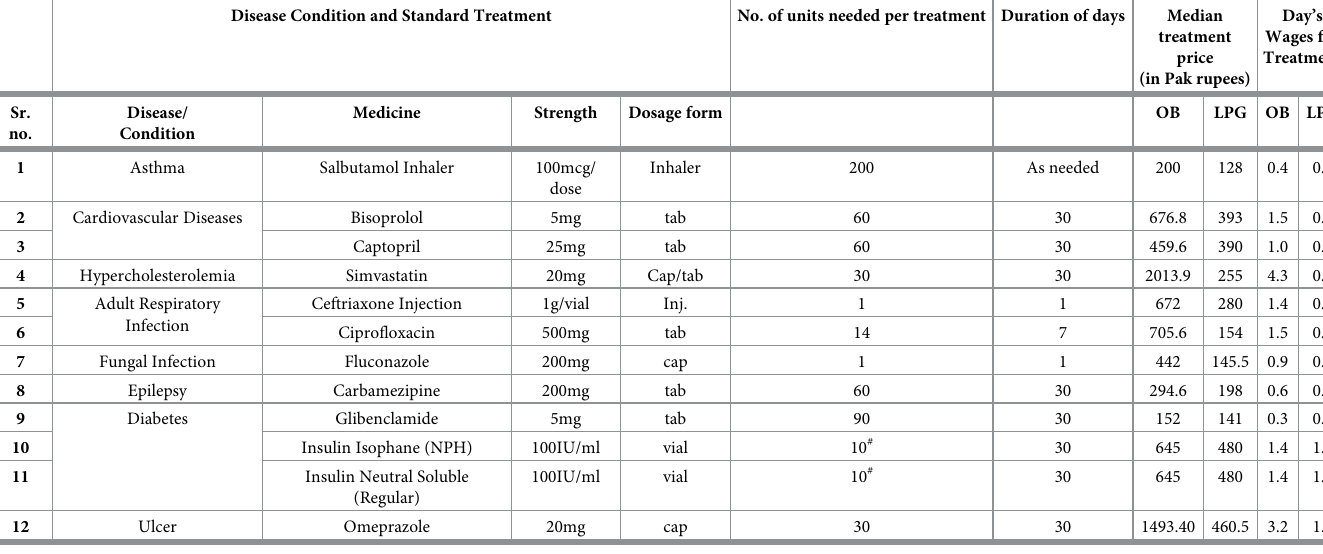
#each unit considered as